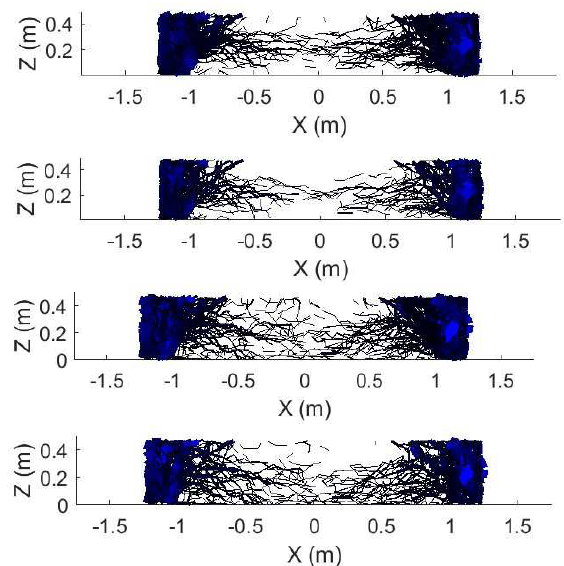
Fig. 6. Evolution of contact forces network in X-Z plane (front view) with a threshold of 450N. The successive steps plotted are: 201, 202, 497, 498. Low-intensity contact force is represented by the thin dark blue lines while the higher contact force intensity is represented by thick blue ones.